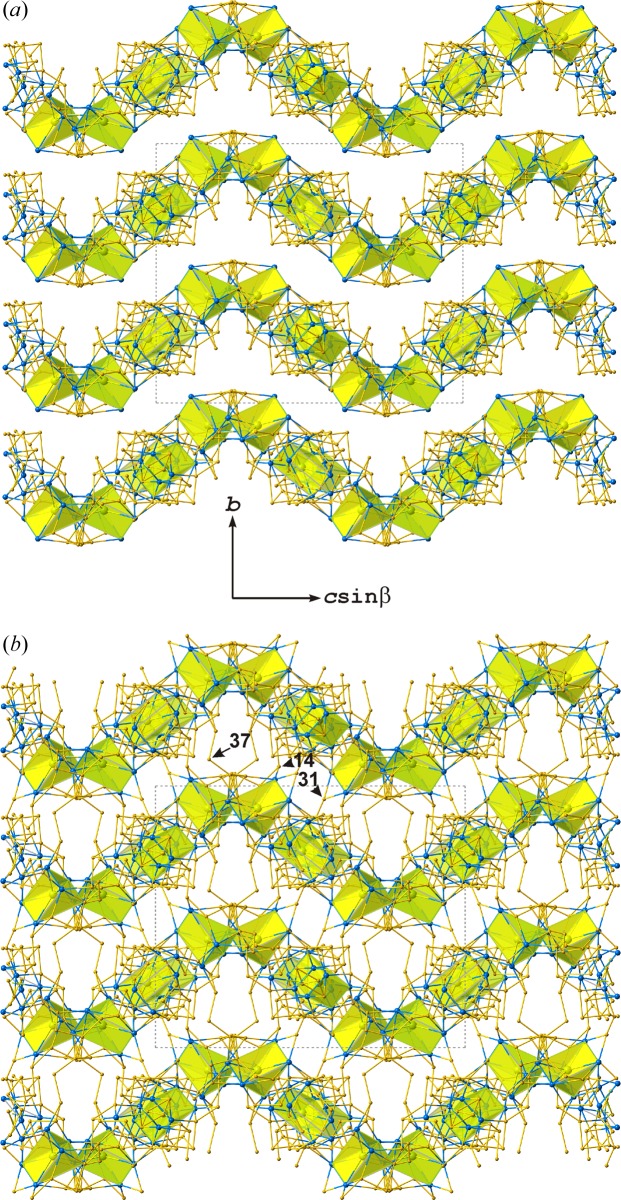
(a) Arrangement of layers of ribbons of TPTS clusters along the b axis and (b) their linkage into a 3D framework via Si14, Si31 and Si37 nodes.